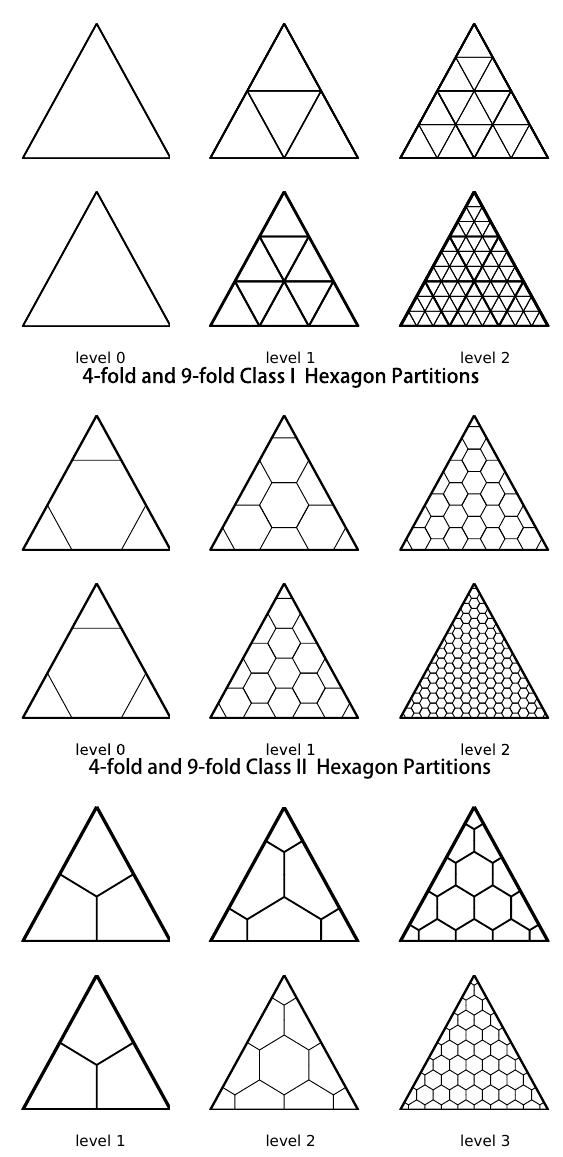
Figure 4. Four- and 9-fold triangular and hexagonal partitioning of a single triangular